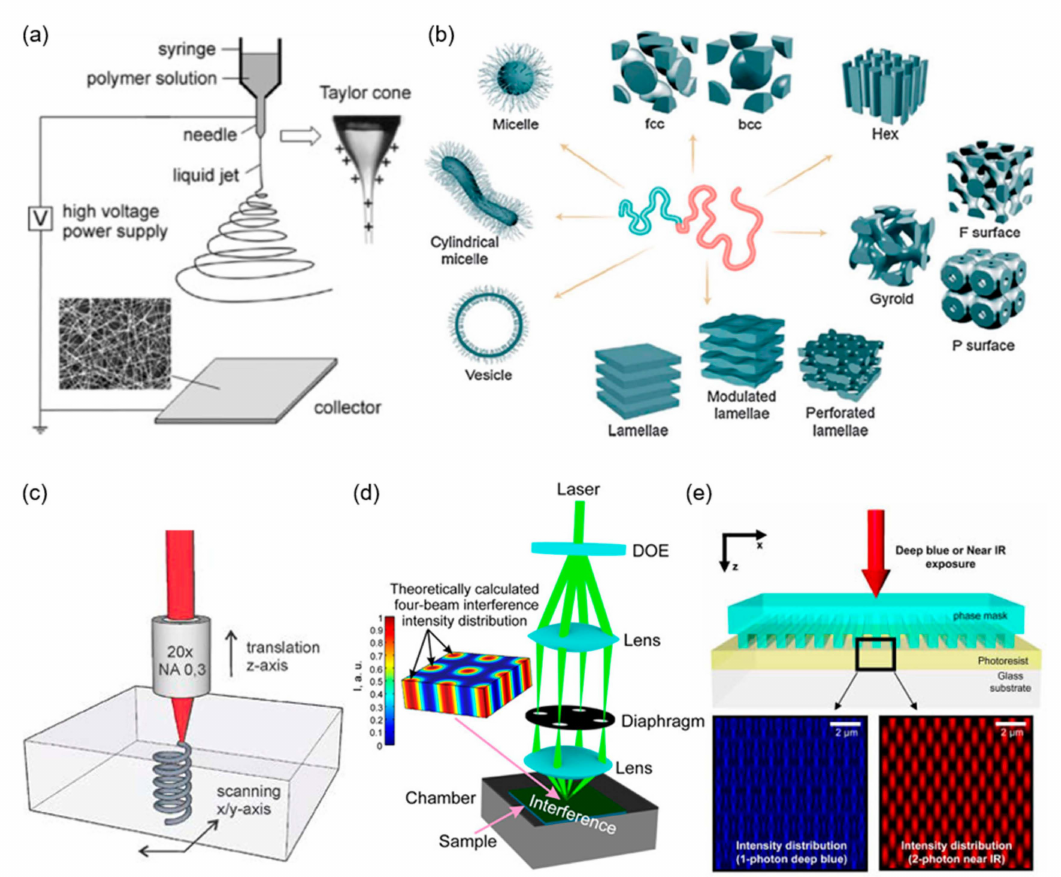
Figure 2. Schematic representation of the fabrication methods of 3D nanonetwork-structured polymer templates: ( a ) electrospinning (reprinted with permission from [37]. Copyright 2004 John Wiley and Sons); ( b ) block-copolymer (BCP) lithography (reprinted with permission from [45]. Copyright 2013 The Royal Society of Chemistry); ( c ) direct laser writing (DLW) (reprinted with permission from [46]. Copyright 2011 The Optical Society (OSA)); ( d ) multibeam interference lithography (MBIL) (reprinted with permission from [47]. Copyright 2011 The Optical Society (OSA)); ( e ) proximity-field nanopatterning (PnP) (reprinted with permission from [48]. Copyright 2006 The Optical Society